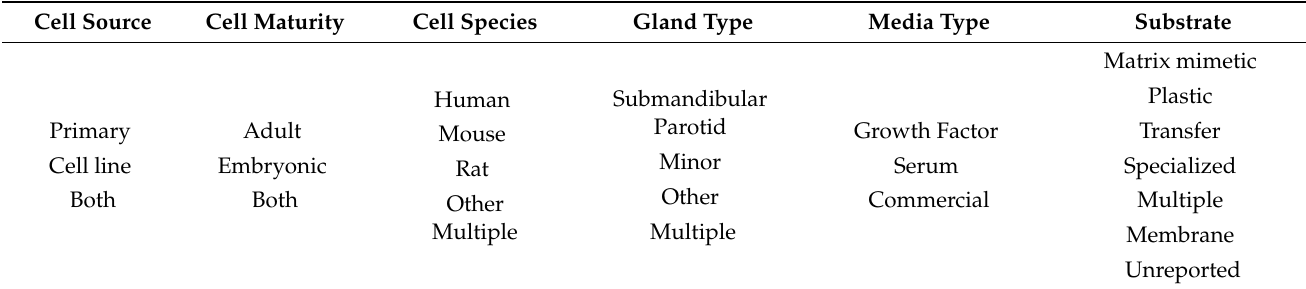
Table 1. Categorization of information extracted from selected